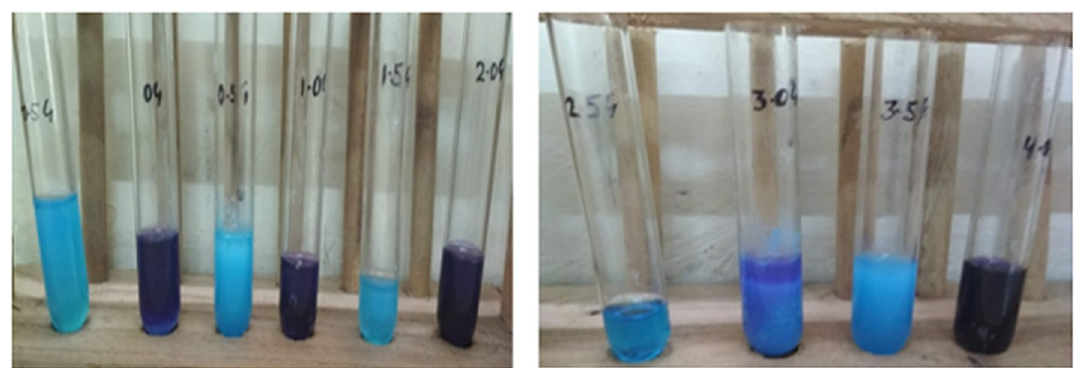
Figure 5. Copper sulphate test results of different generations of